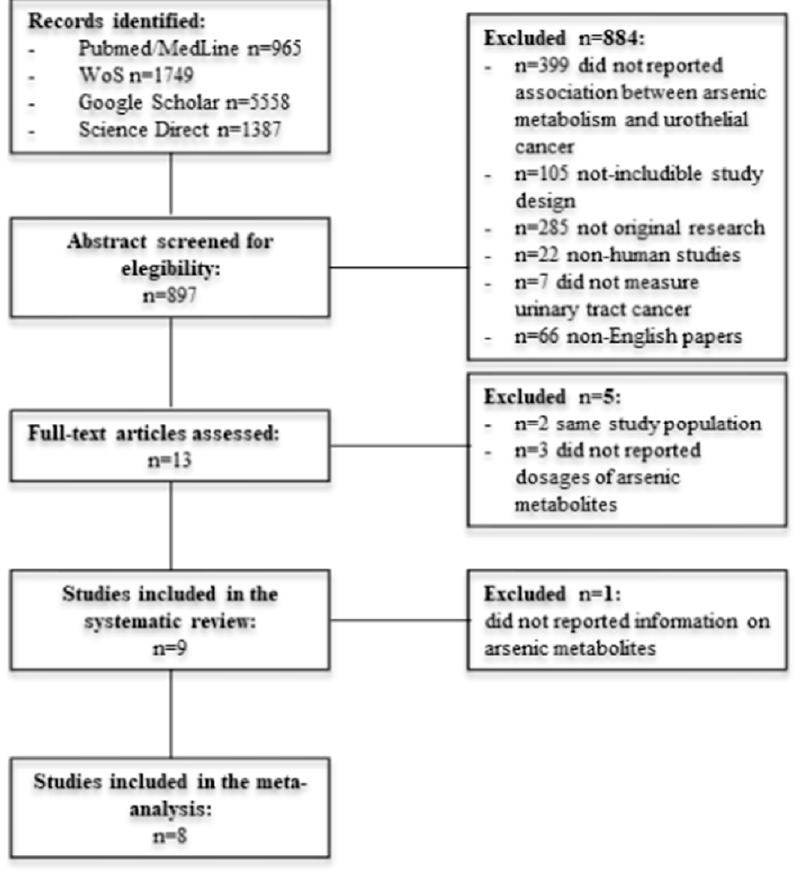
Figure 1. Flowchart of the study selection.